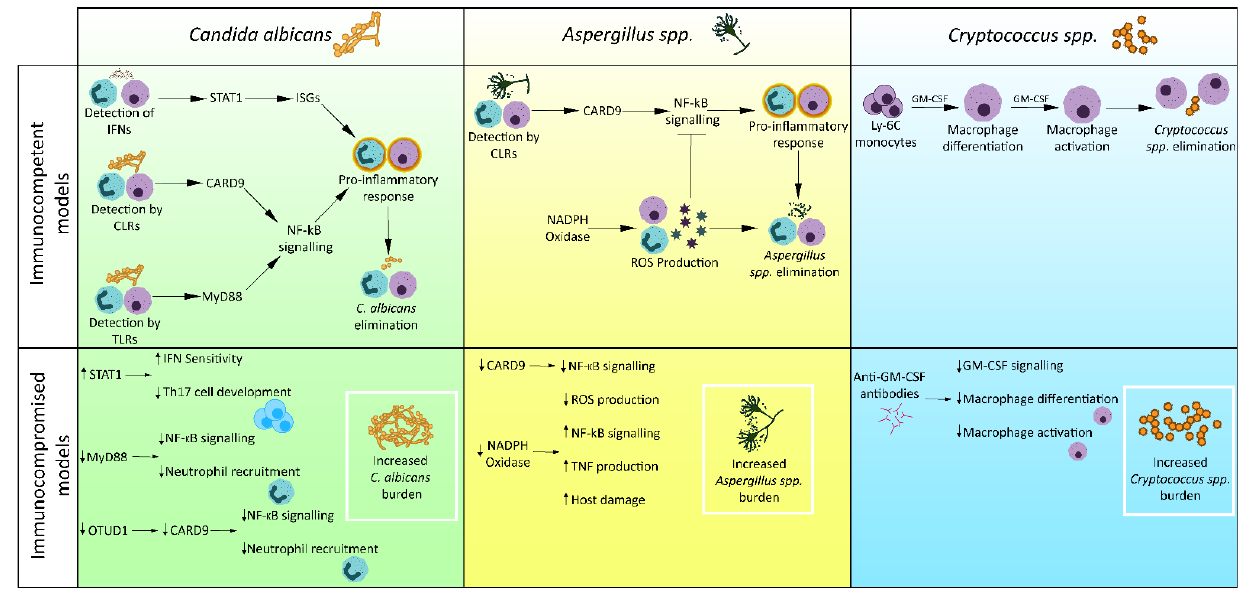
Figure 2. Failures of innate immunity in fungal infection. Examples of specific failures of innate immunity which lead to susceptibility to fungal infection. STAT1 gain of function mutations increase sensitivity to IFNs, leading to increased susceptibility to fungal infections [131]. OTUD1 or MyD88 deficiencies result in reduced transcription of NF ‐κ B, resulting in reduced inflammatory response and increased C. albicans burden [135,138]. CARD9 deficiency causes reduced NF ‐κ B transcription, resulting in reduced inflammatory response and increased A. fumigatus burden [147]. NADPH oxidase deficiency in CGD patients reduced produc ‐ tion of ROS, reducing the ability to kill A. fumigatus and removing ROS ‐ mediated inhibition of NF ‐κ B, resulting in excess TNF production and host injury [41,131]. Anti ‐ GM ‐ CSF antibodies prevent macrophage differentiation and activation, resulting in inability to control C. neoformans infection [148].